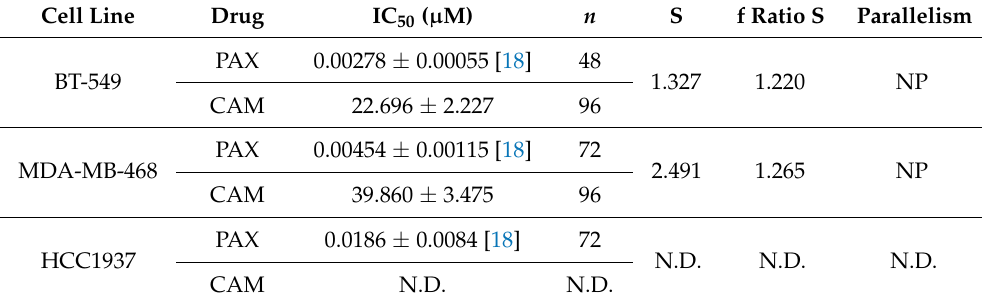
Table 1. Median inhibitory concentrations (IC 50 ± SEM) for the PAX [18] and CAM in BT-549, MDA-MB-468 and HCC1937 TNBC cells. The IC 50 values (in µ M ± SEM) for PAX and CAM,